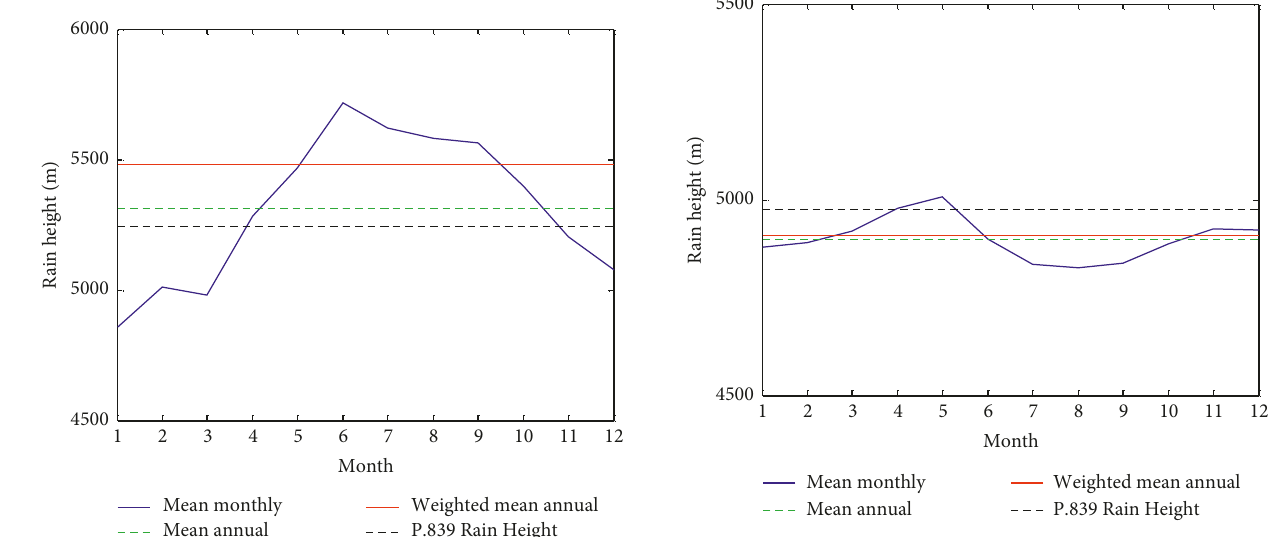
Figure 8: Comparison between different mean rain heights in